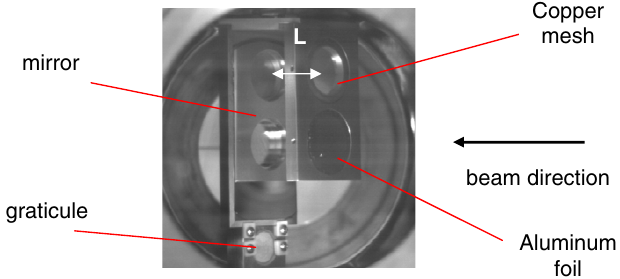
FIG. 8. (Color) Target ladder showing ODTR and OTR Interferometers, mirror, and graticule.